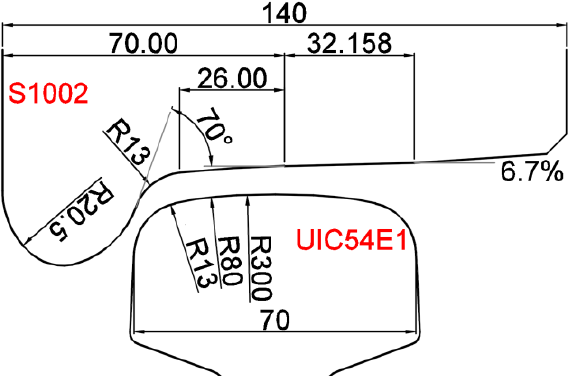
Figure 7. UIC54 E1 rail profile and S1002 wheel profile applied in the multi-body system (MBS) model (dimensions in mm).